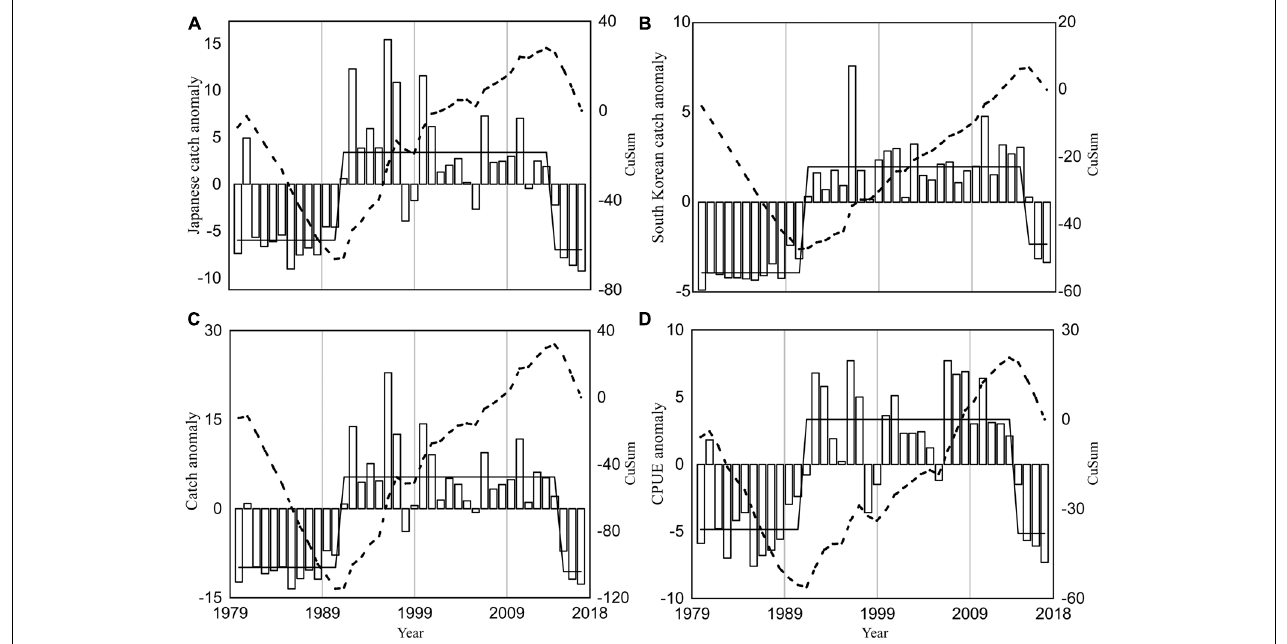
FIGURE 3 | Annual anomalies (white bars) for Japanese catch (A) , South Korean catch (B) , total catch (C) and a combination of Japanese and South Korean CPUE (D) of winter cohort of Japanese flying squid from 1979 to 2018. The black dash line shows the cumulative sum (CuSum) of anomalies and black solid line represents the regime shifts detected by